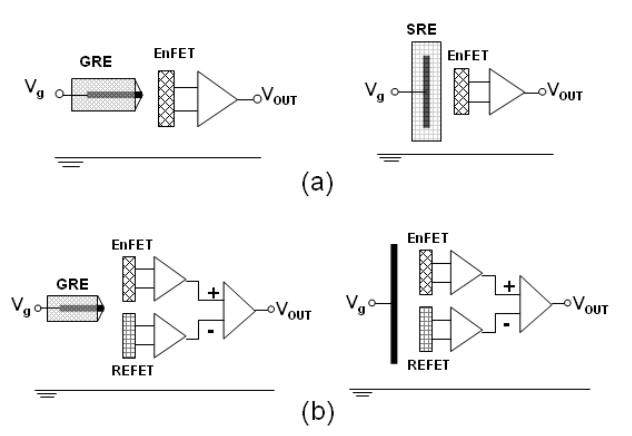
Figure 3. Test structures: (a) single-ended (b) two-ended differential